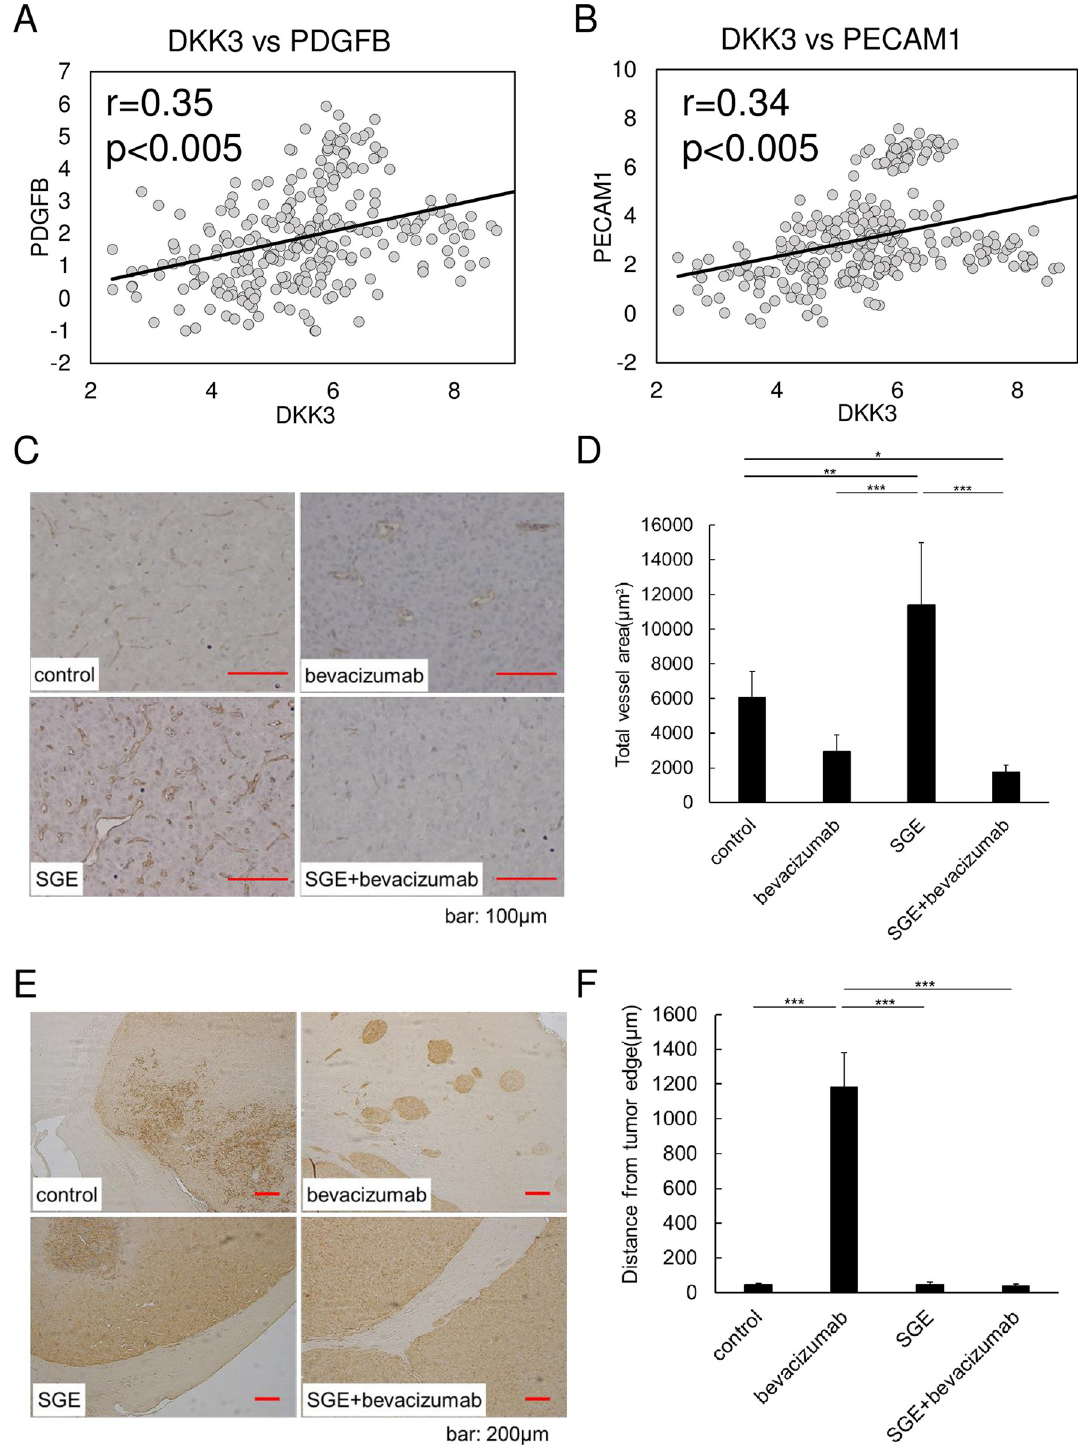
Fig 5. Anti-angiogenic effect of bevacizumab and anti-invasiveness effect of Ad-SGE-REIC. (A–B) Analysis of TCGA GBM dataset showed the positive correlation between Dkk3 expression and angiogenesis markers. (C–D) Tumor vessels were identified with CD31. Untreated U87 Δ EGFR orthotopic tumor was observed with angiogenic growth. Bevacizumab significantly decreased the vessel density of tumors; the vessel density of the Ad-SGE-REIC-treated group was significantly increased compared with the control. In the combination treatment of Ad-SGE-REIC with bevacizumab, the vessel density was significantly decreased compared with Ad-